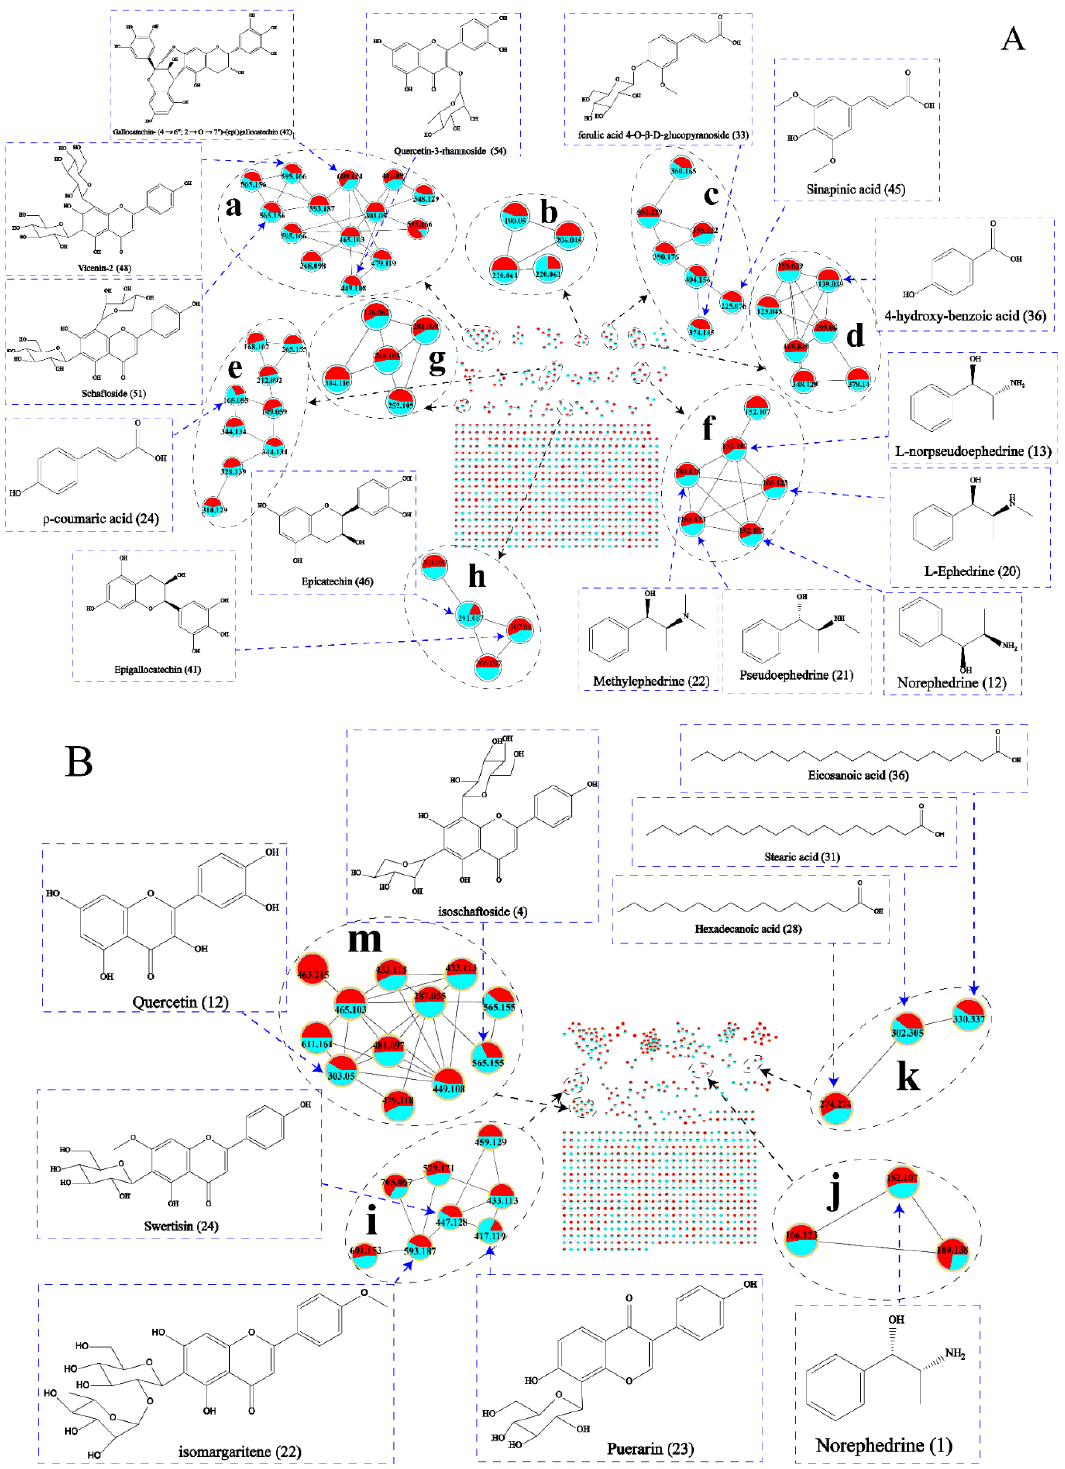
Figure 2. The molecular network of raw Ephedrae herba and honey-processed Ephedrae herba ( A ): fraction P1; ( B ) fraction P2). MN for the nodes annotated as “flavonoid and flavonoid glycosides” class ( a , h , i , and m ). MN for the nodes annotated as “quinolinic acids” class ( b ). MN for the nodes annotated as “phenolic acids” class ( c , d , and e ). MN for the nodes annotated as “alkaloids” class ( f , g , j and k ). The pie chart for nodes was filled with different colors, red (raw Ephedrae herba) and blue (honey-processed Ephedrae herba), based on the proportion of the intensity of the ion peak corresponding to each metabolite in the two decoction